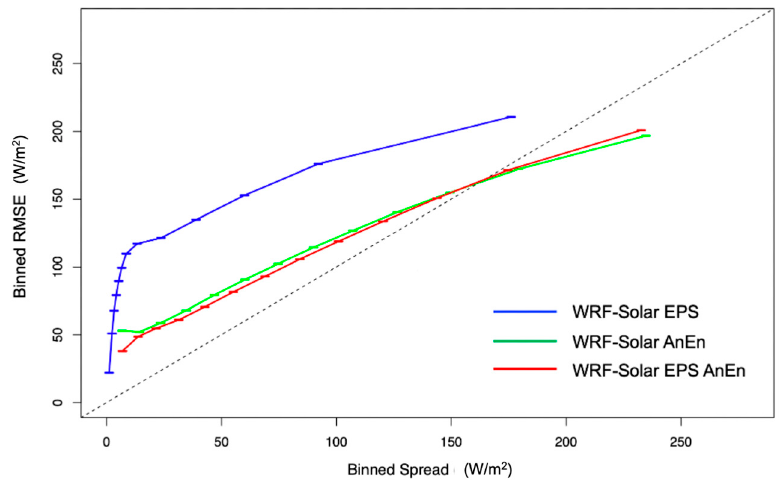
Figure 7. Binned RMSE/spread diagrams computed pooling all the grid points for GHI forecasts, runs, and the forecast lead times from +24 to +48 h for 2018. The horizontal bars represent the 5–95% bootstrap confidence intervals of the spread for each considered bin.